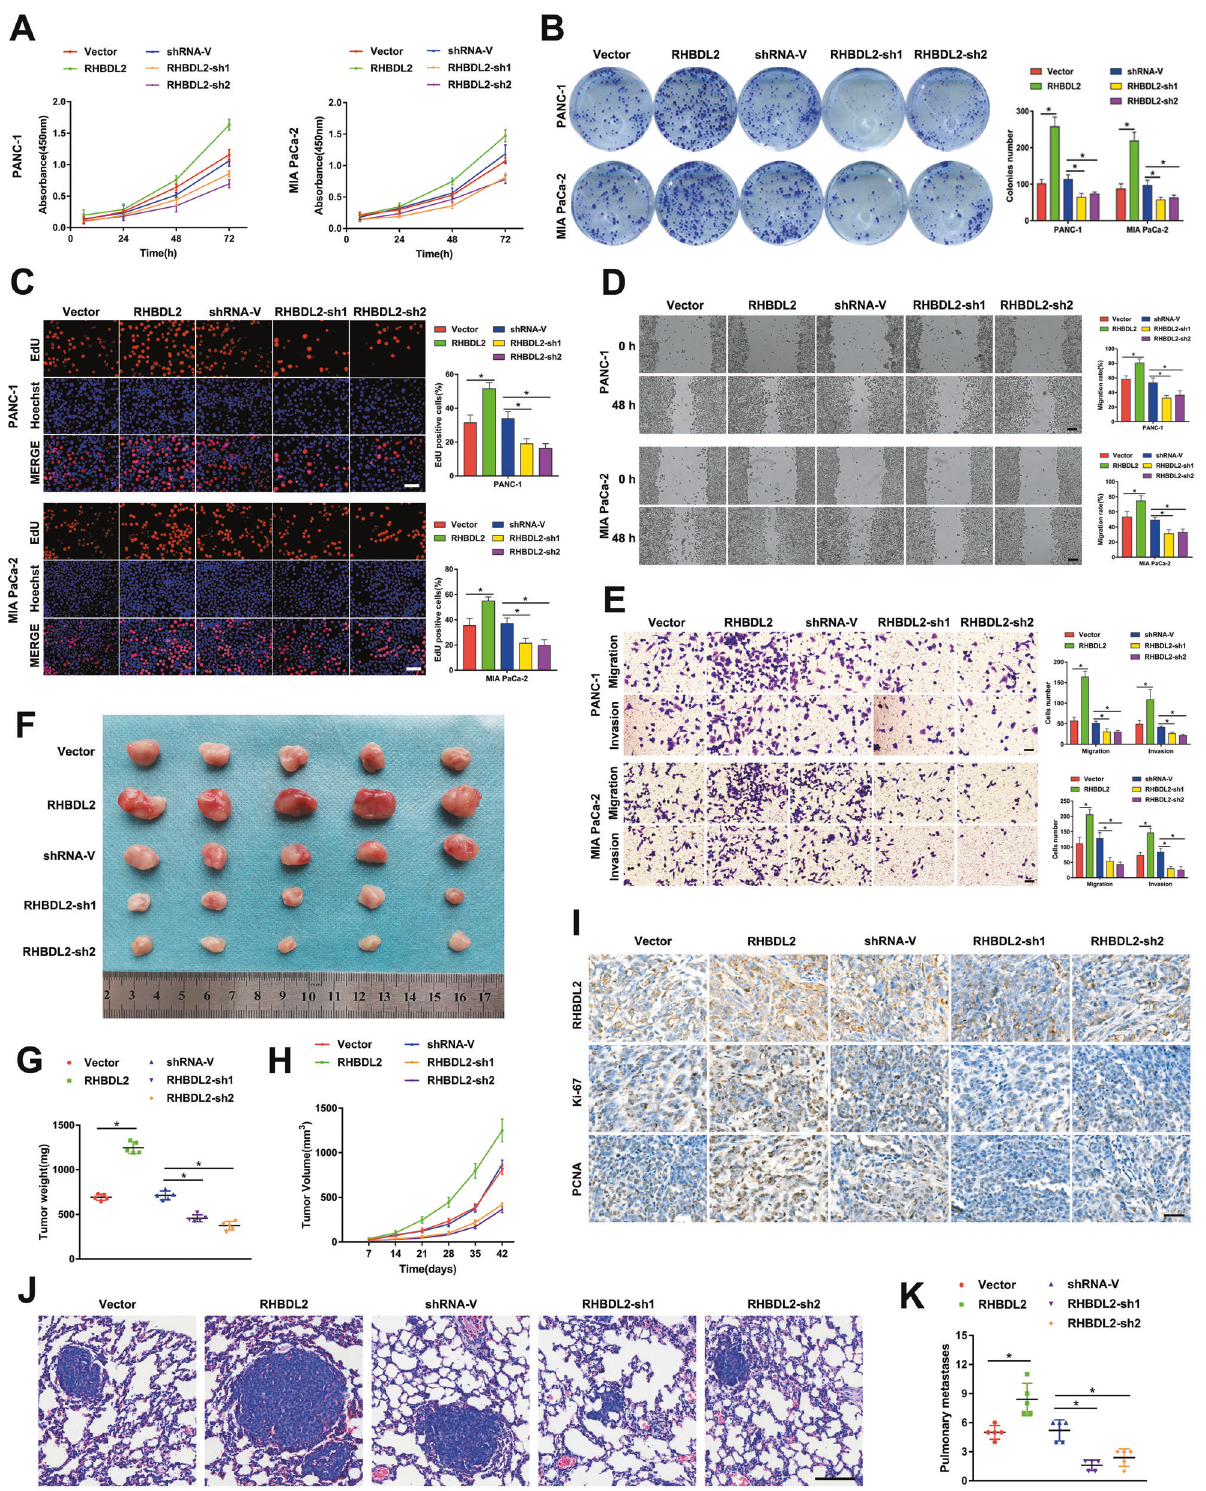
Fig. 2 RHBDL2 promotes proliferation and mobility of PC cells in vitro and in vivo. CCK-8 ( A ), colony formation ( B ), and EdU (scale bar: 50 μ m) ( C ) assays were used to evaluate the proliferation capacity of the RHBDL2-overexpressing, RHBDL2 downregulated, and corresponding negative control cells. The mobility of the indicated PC cells was veri fi ed by wound healing (scale bar: 100 μ m) ( D ) and Transwell assays (scale bar: 50 μ m) ( E ). Subcutaneous xenograft tumors ( F ), tumor weight ( G ), and tumor volume ( H ) in nude mice ( n = 25). I IHC staining of RHBDL2 and the levels of Ki-67 and PCNA in the indicated tumors resected from the nude mice. Scale bar: 50 μ m. Representative images of the tail vein-injected mouse models (scale bar: 100 μ m) ( J ), and the lung foci number was evaluated ( K ), ( n = 25). * P < 0.05.